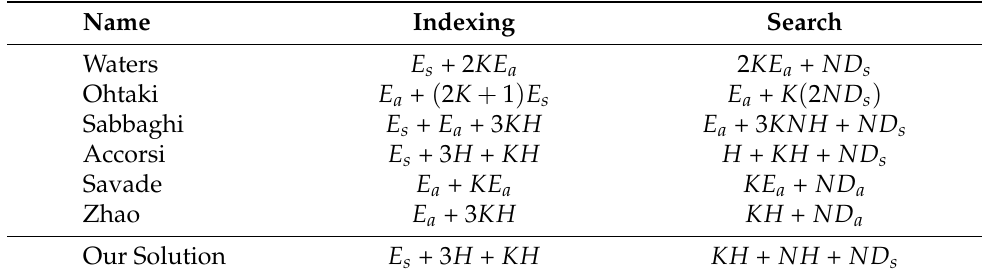
Table 2. Comparison of indexing and search